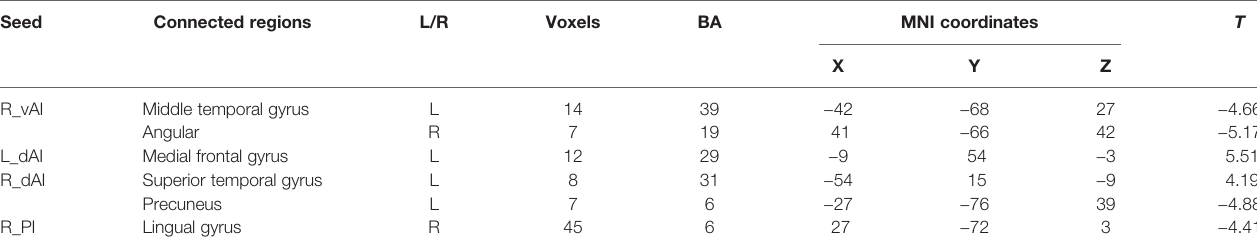
TABLE 3 | Group differences in seed-based functional connectivity of the insular